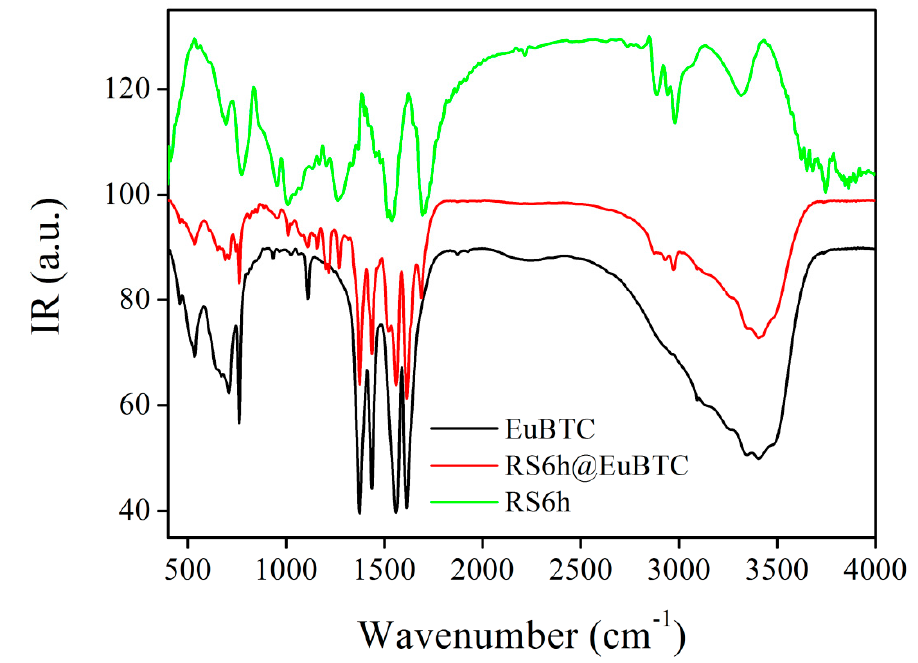
Figure 3. IR spectra of EuBTC, RS6h@EuBTC and RS6h.